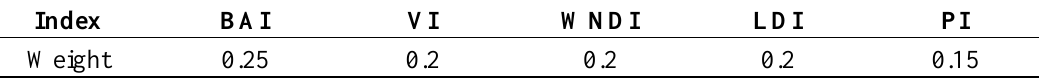
Table 1. The weight of each index in EQI.